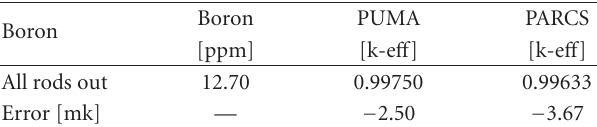
Table 11: CNA-I cold